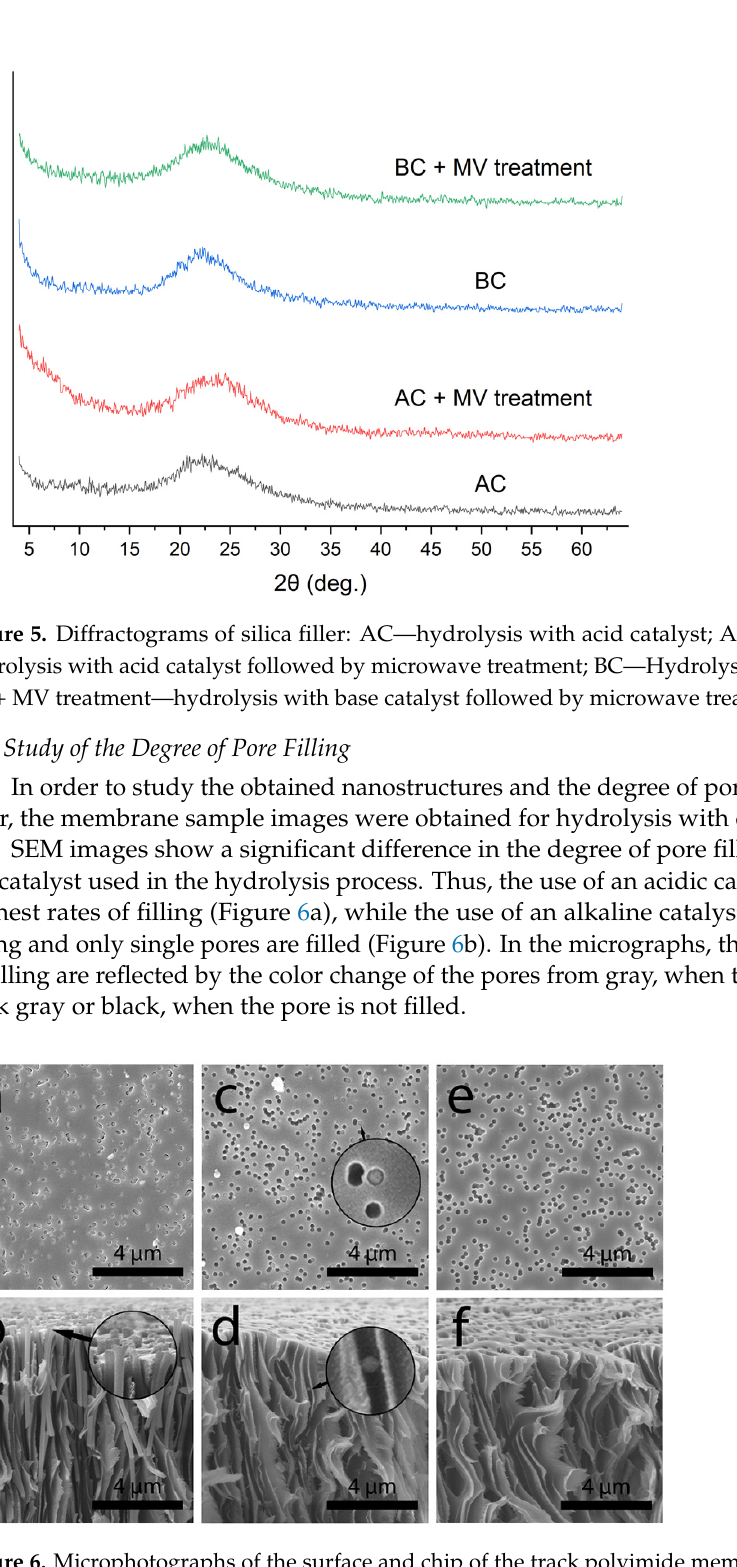
Figure 6. Microphotographs of the surface and chip of the track polyimide membrane: ( a , b ) hydrolysis with acidic catalyst followed by microwave treatment; ( c , d ) hydrolysis with base catalyst followed by microwave treatment; ( e , f ) clean track-etched polyimide membrane .